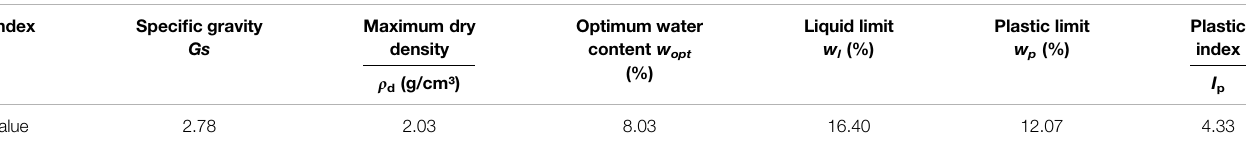
TABLE 1 | Physical properties of glacial till